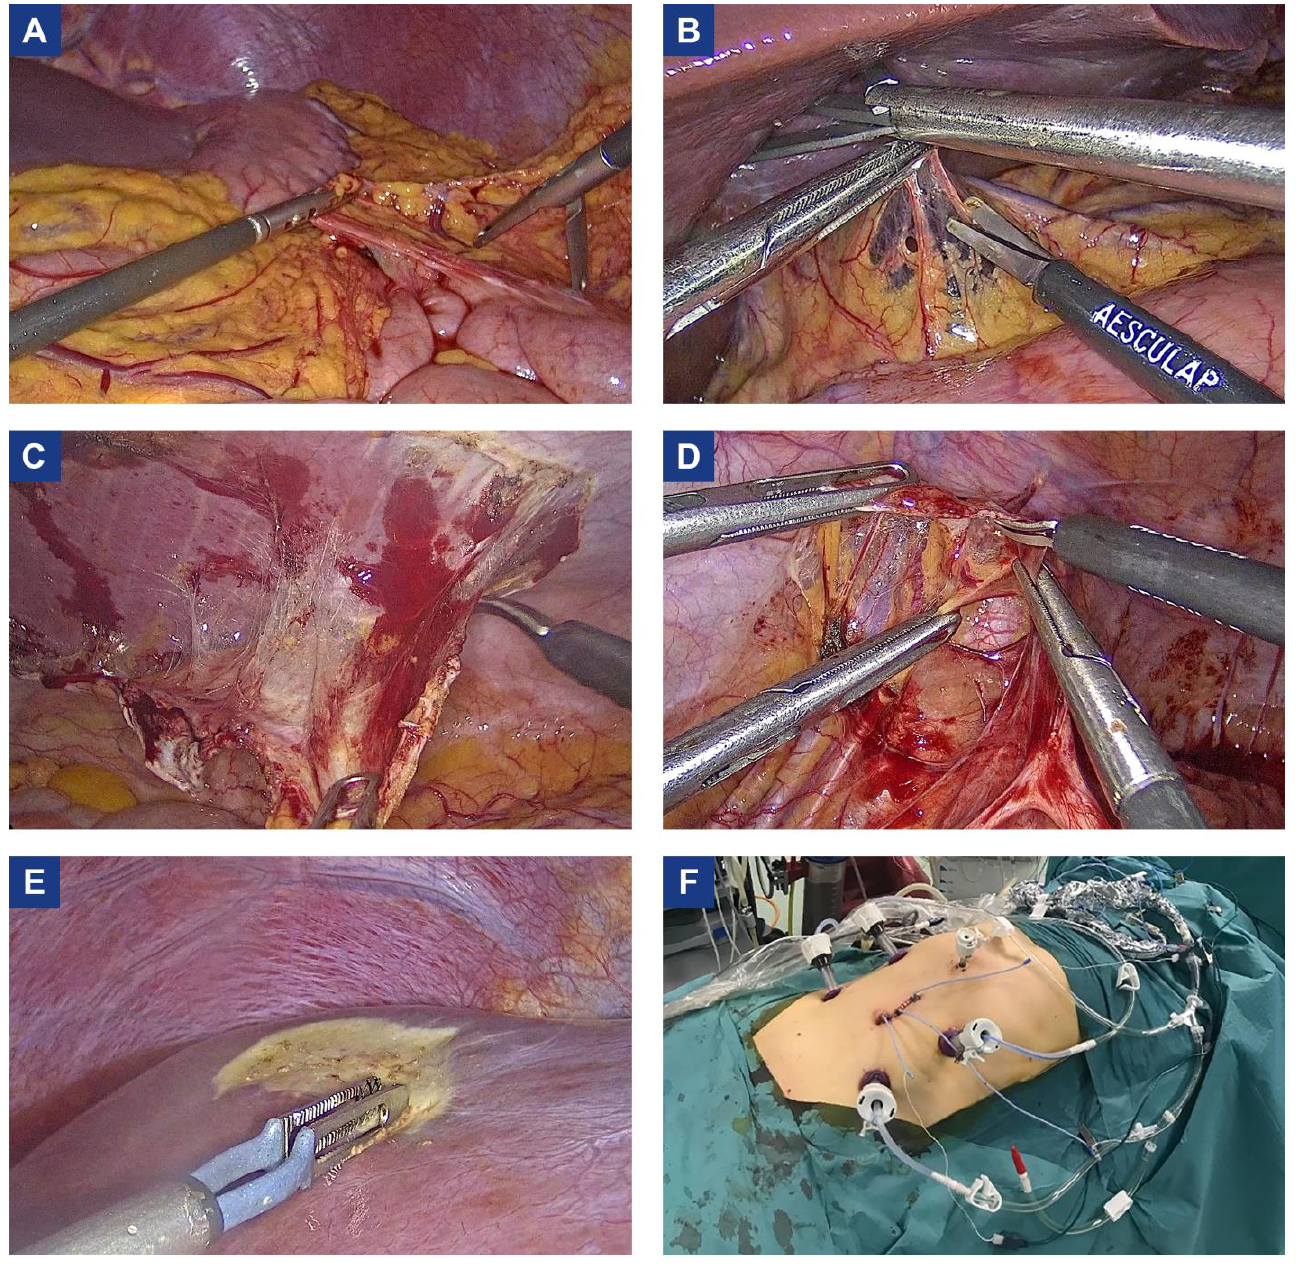
Figure 2. Representative images of laparoscopic cytoreductive surgery and HIPEC. ( A ) Greater omentectomy; ( B ) Lesser omentectomy; ( C ) Parietal peritonectomy; ( D ) Pelvic peritonectomy; ( E ) Glisson’s capsule electroevaporation; ( F ) HIPEC circuit.